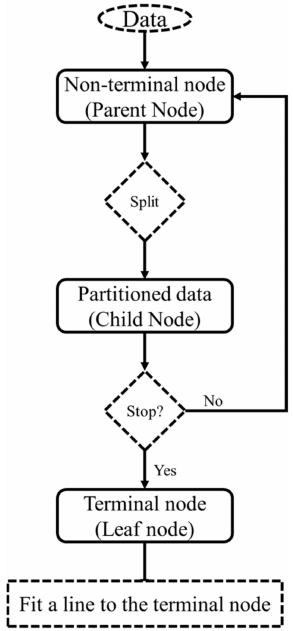
Figure 2. The schematic representation of the binary MT induction in the MTG